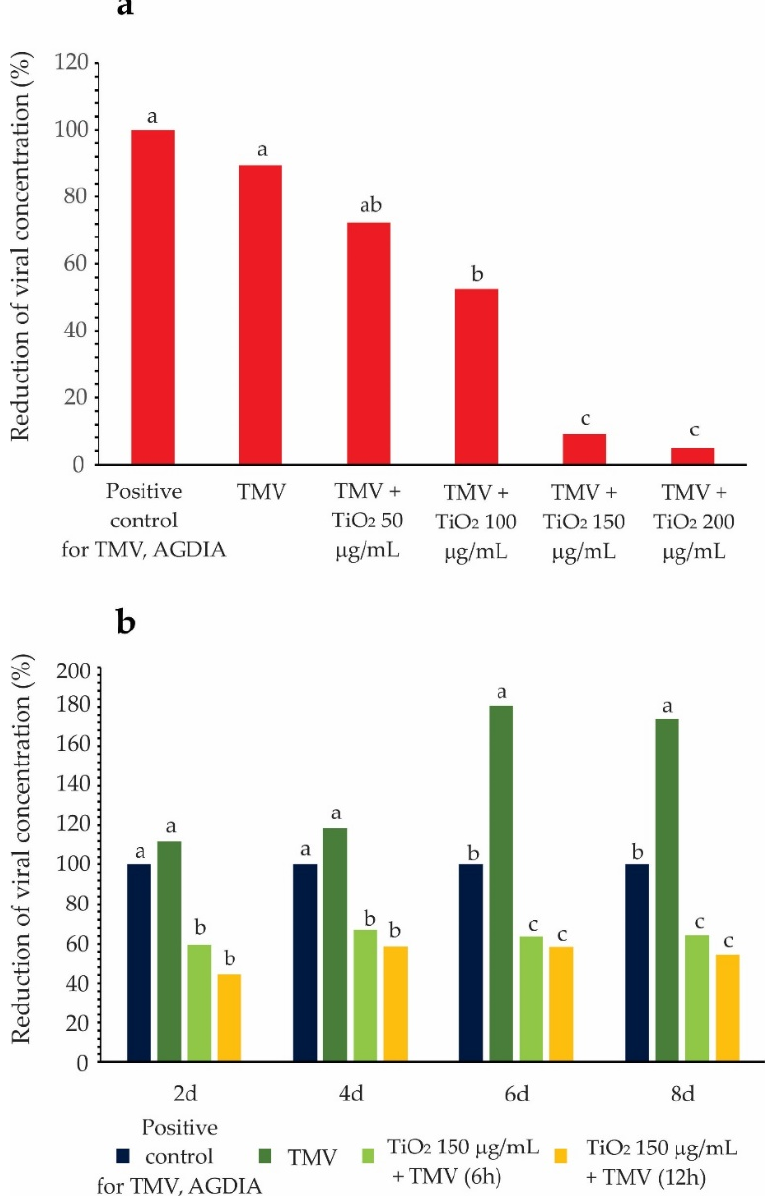
Figure 5. ( a ) TMV concentration in plants treated with TiO 2 NPs. ( b ) TMV concentration in reactivity test. The letters indicate the significant difference between treatments ( α = 0.05).